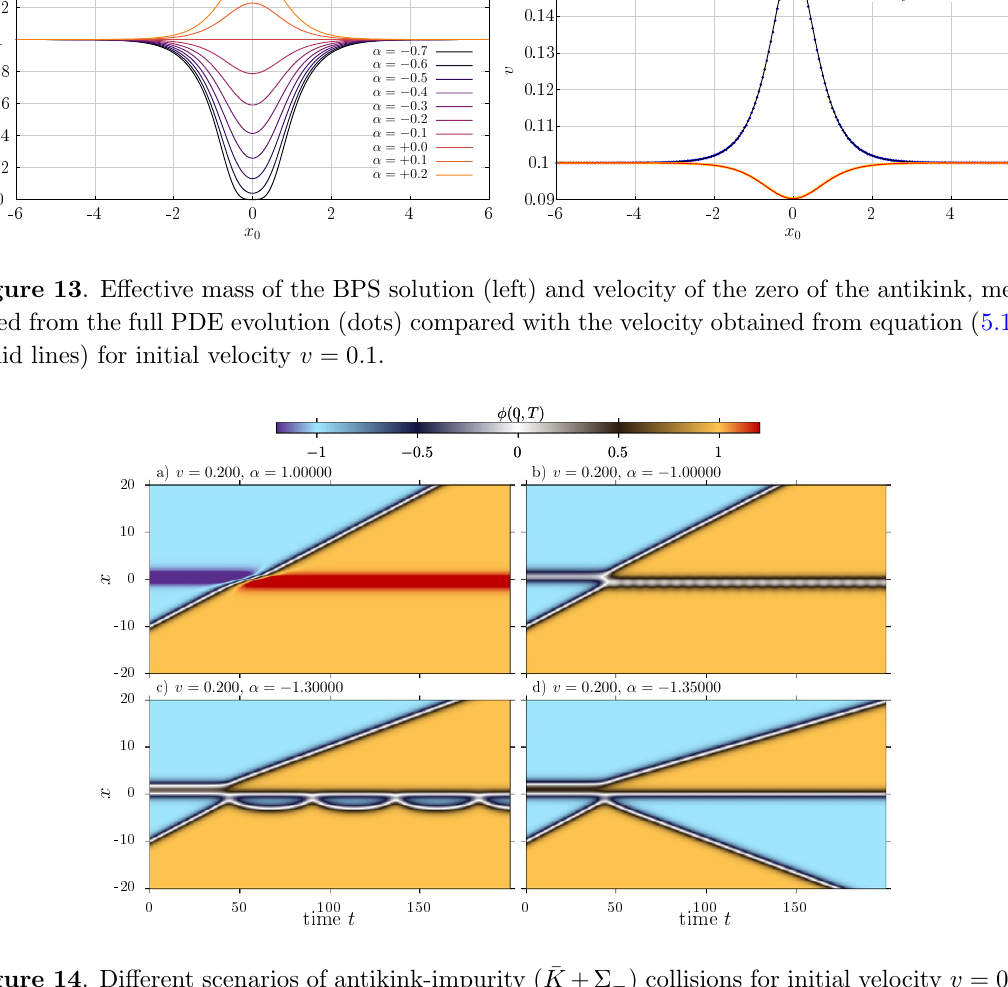
Figure 14 . Di(cid:11)erent scenarios of antikink-impurity ( (cid:22) K + (cid:6) (cid:0) ) collisions for initial velocity v = 0 : 2. The parameter values in the di(cid:11)erent plots are a) (cid:11) = 1, b) (cid:11) = (cid:0) 1, c) (cid:11) = (cid:0) 1 : 3 and d) (cid:11) = (cid:0) 1 :